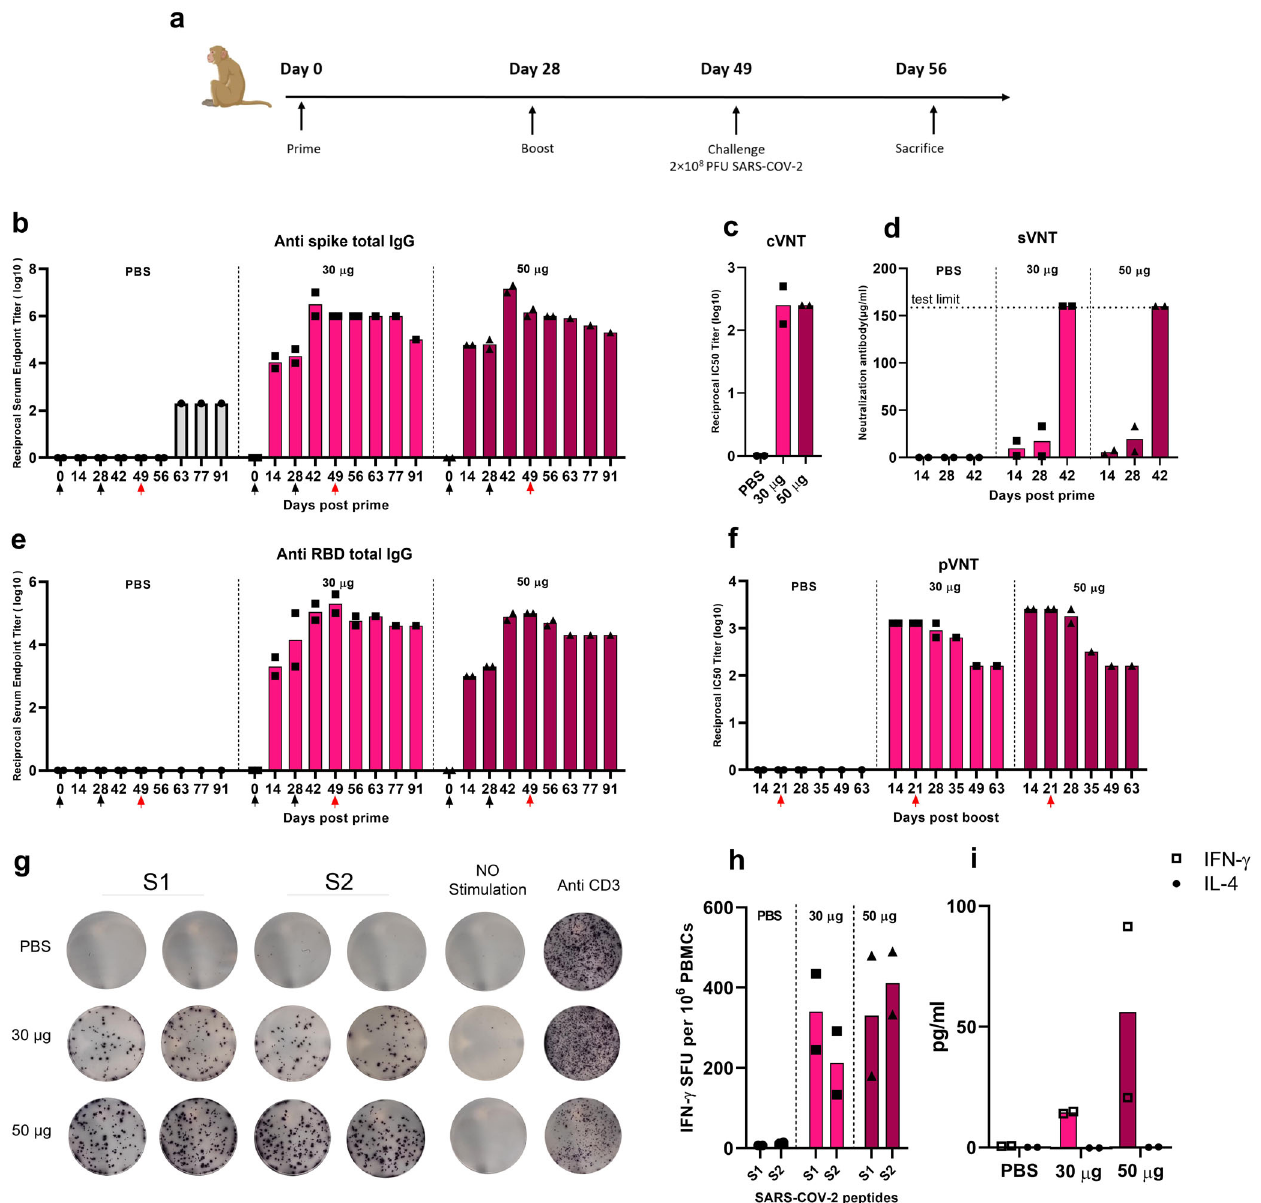
Fig. 5 Induction of ef fi cient humoral and cellular immunity in non-human primates by COReNAPCIN ® . a Rhesus macaques ( n = 2 each group) were immunized with either 30 µg (pink) or 50 µg (purple) COReNAPCIN ® at days 0 and 28 and were challenged with 2 × 10 8 PFU of SARS-CoV-2, 21 days after the boost injection. Animals in the control group were administrated with PBS (gray). b – f Serum samples were subjected for evaluating the COReNAPCIN ® induced humoral immune responses. The black arrows under the x-axis represent vaccination days while the red one denotes the challenge day. The titer of anti-Spike ( b ) and anti-RBD ( d ) speci fi c IgG binding antibody in sera before prime and eight indicated time points post prime were determined by ELISA. The neutralizing capacity were assessed in the sera of day 14 post boost by cVNT ( c ), and in the sera of indicated different time points by sVNT ( d ) and pVNT ( f ). g – i PBMCs isolated 21 days post-boost injection, were subjected for assessing the COReNAPCIN ® induced cellular immune response. Using an ELISpot assay ( g , h ), after 24 h stimulation with SARS-CoV-2 peptide pool (S1 and S2), the frequency of IFN- γ producing cells per 10 6 splenocytes were quanti fi ed ( h ). In ( g ), the representative images of ELISpot wells, columns from left to right are: responses of PBMCs to S1 and S2 SARS-CoV-2 peptide pool (as duplicate), DMSO (a negative control), and Anti CD3 (an unspeci fi c positive control). Each row represents an individual rhesus macaque. An ELISA assay ( i ) was used to assess the IFN- γ (square shape symbol, □ ) and IL-4 (circle shape symbol, ● ) cytokine level in the cell culture supernatants following 8 h stimulation with SARS-CoV-2 peptide pool. In bar plots, each data point is shown and the height of each bar represents the